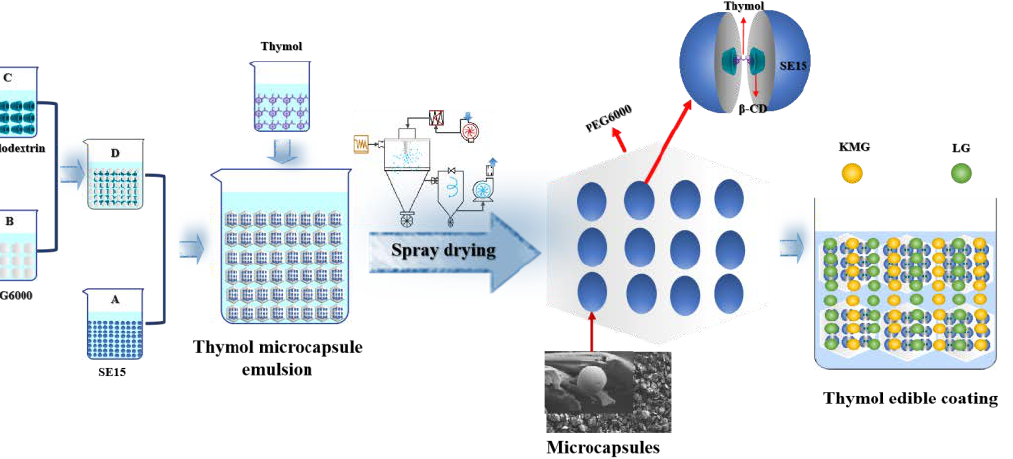
Figure 1. Flow chart of TKL coating solution preparation. β -cyclodextrin ( β -CD); polyethylene glycol 6000 (PEG6000); and sucrose fatty acid ester (SE15).